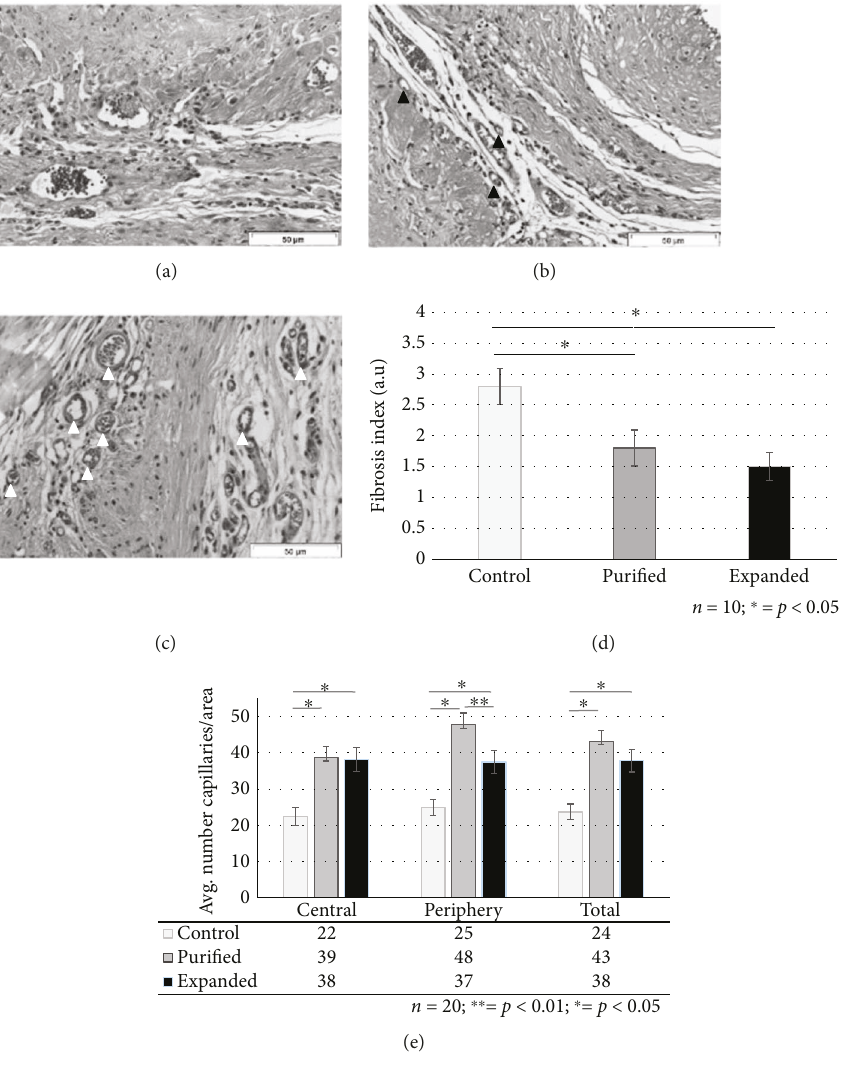
Figure 4: Either puri fi ed CD133 + cells or expanded CD133 + cells decreased fi brosis and increased angiogenesis of rat hearts that underwent AMI. Representative photomicrographs of myocardial tissue sections in the infarct region of the three groups: control (a), transplanted with puri fi ed CD133 + cells (b), and expanded CD133 + cells (c). Control=control group, injected with isotonic saline solution (sodium chloride 0.9%). Puri fi ed=transplanted with puri fi ed CD133 + cells. Expanded =transplanted with expanded CD133 + cells. Semiquantitative analyses of cross-sectional areas were carried out to determine the level of fi brosis in the infarcted region of the heart (d) and the level of vascularization in the central/periphery regions of the heart (e) (for further details, see Materials and Methods). The control group presented less capillaries than the groups treated with CD133 + cells. The presence of many well-developed vessels was observed in animals transplanted with expanded CD133 + cells (white arrowheads in (c)). Structures resembling recently formed capillaries with one or without red blood cells were identi fi ed in rats transplanted with puri fi ed CD133 + cells (black arrowheads in (b)). The bars in graphs (d) and (e) represent the mean ± the standard error. Scale bars: 50 μ